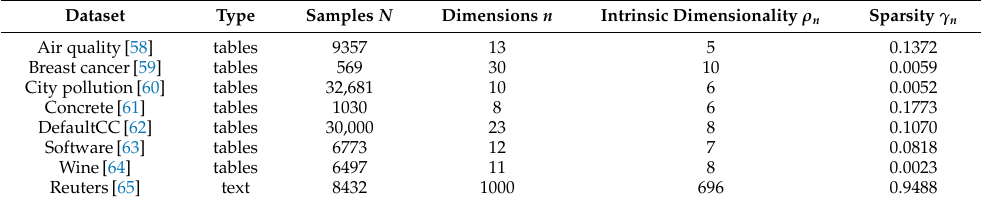
Table 1. Selected datasets for evaluation and their trait values (Section